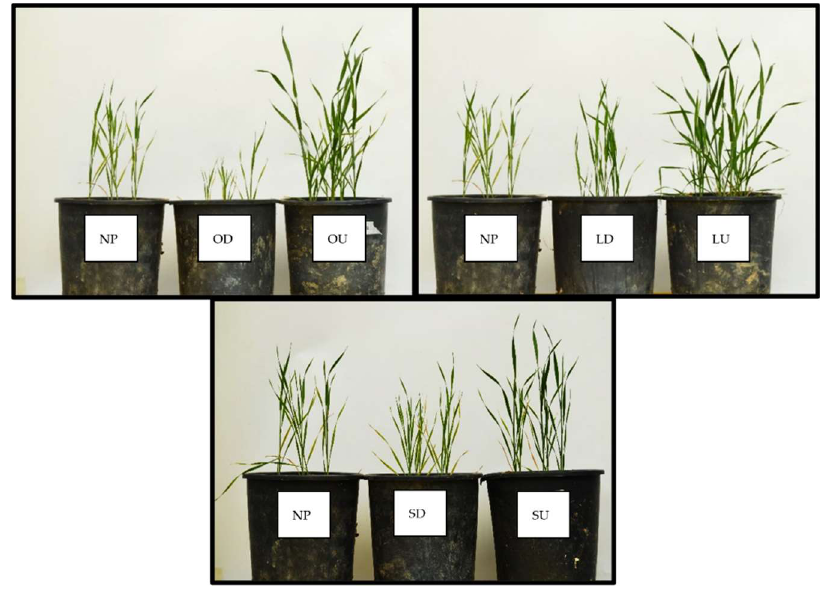
Figure 2. Comparison of wheat growth 21 days after planting. OD: after O. compressus under disturbed treatment; OU: after O. compressus under undisturbed treatment; LD: after L. rigidum under disturbed treatment; LU: after L. rigidum under undisturbed treatment.